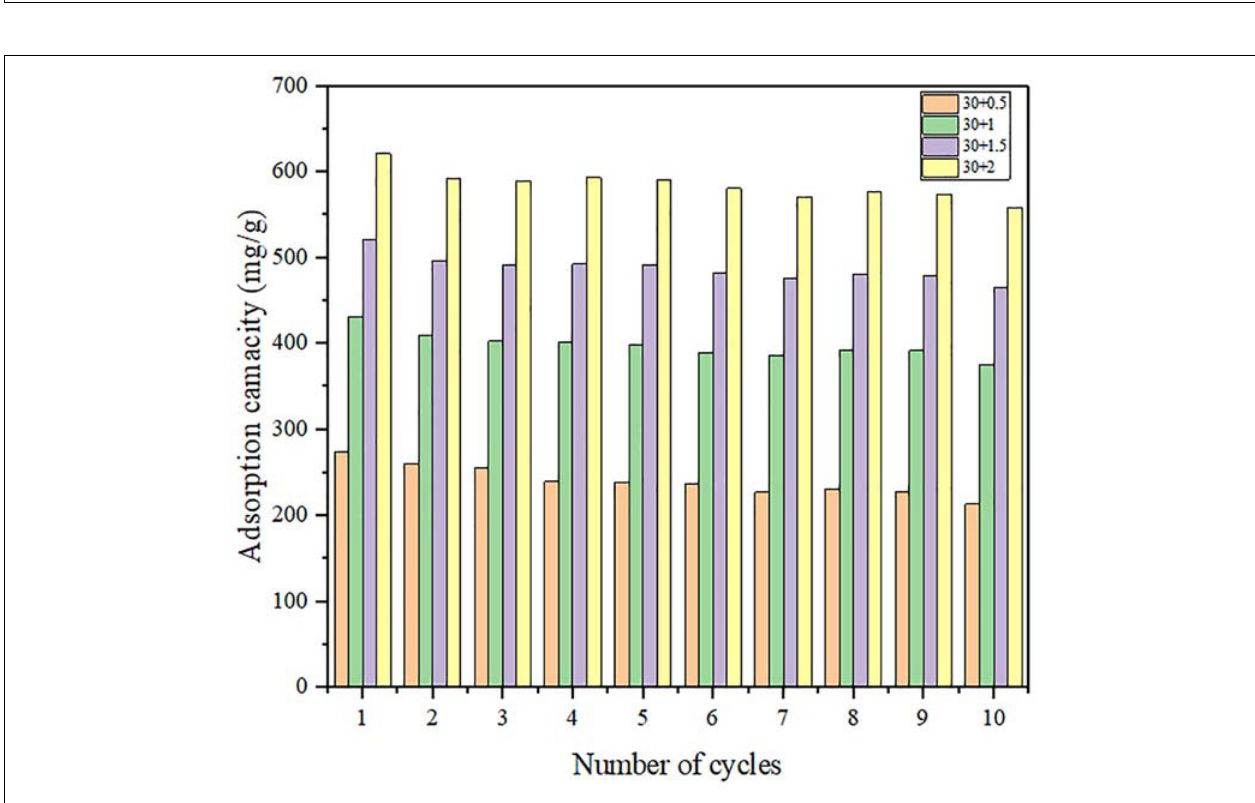
FIGURE 12 | Maximum water adsorption capacity of multiple cycles under actual working conditions.